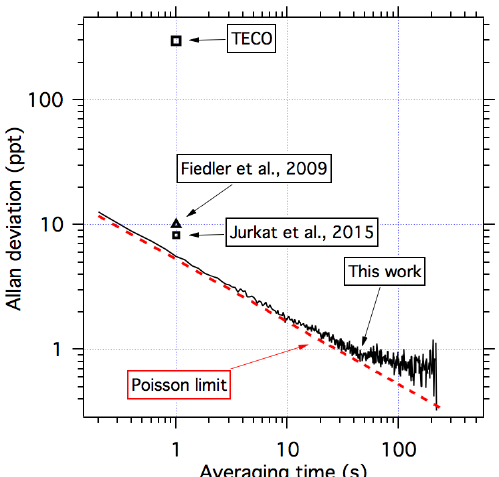
Figure 11. Instrument precision (Allan deviation) during a 1.2h segment sampling an average SO 2 abundance of 3.1ppt in the LS during the 28 October flight compared to the expected precision (Poisson limit). Other points show 1 σ precision values for a com- mercial pulsed-fluorescence instrument (TECO) and two CIMS in- struments (Jurkat et al., 2015; Fiedler et al., 2009).